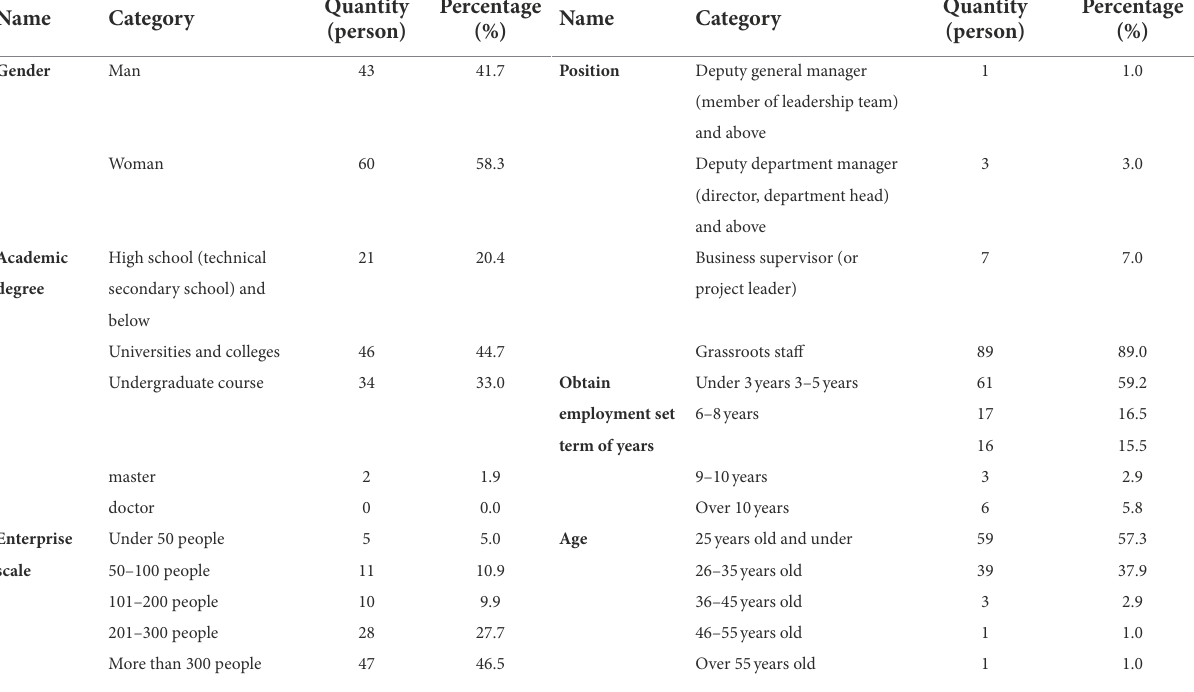
TABLE 1 Descriptive statistical results of population characteristics of valid